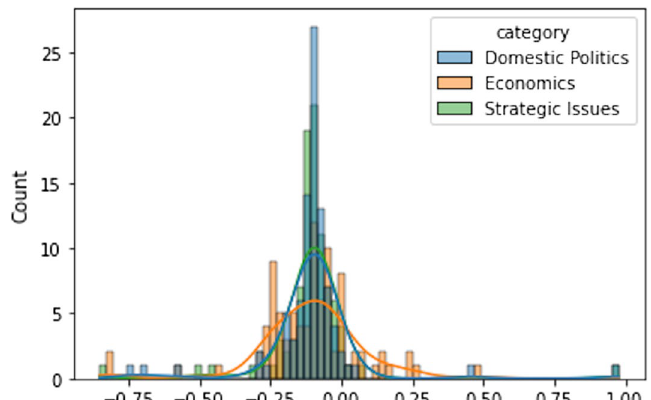
Fig. 8 Distribution of average sentiment score for each category